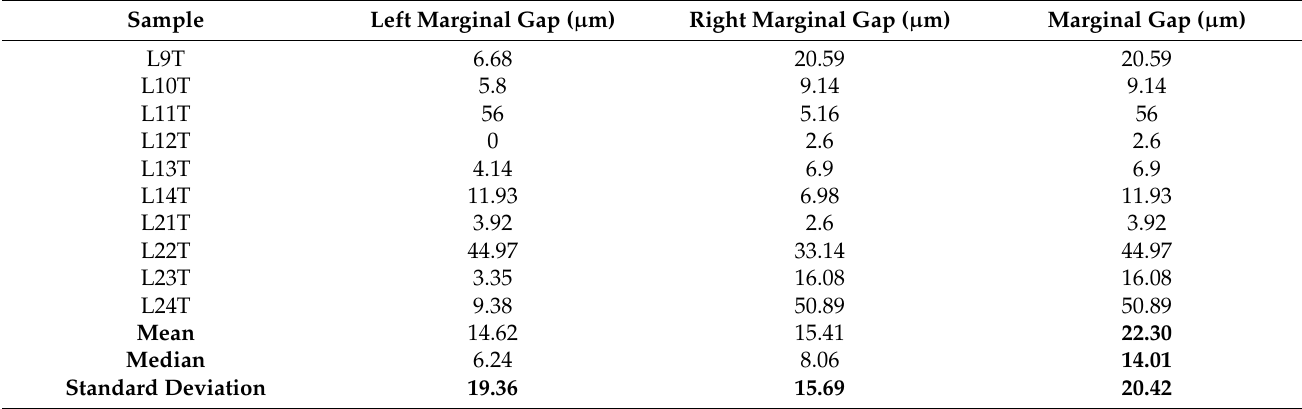
Figure 6. Microleakage in a specimen of control group. Table 3. Marginal adaptation in the study group.